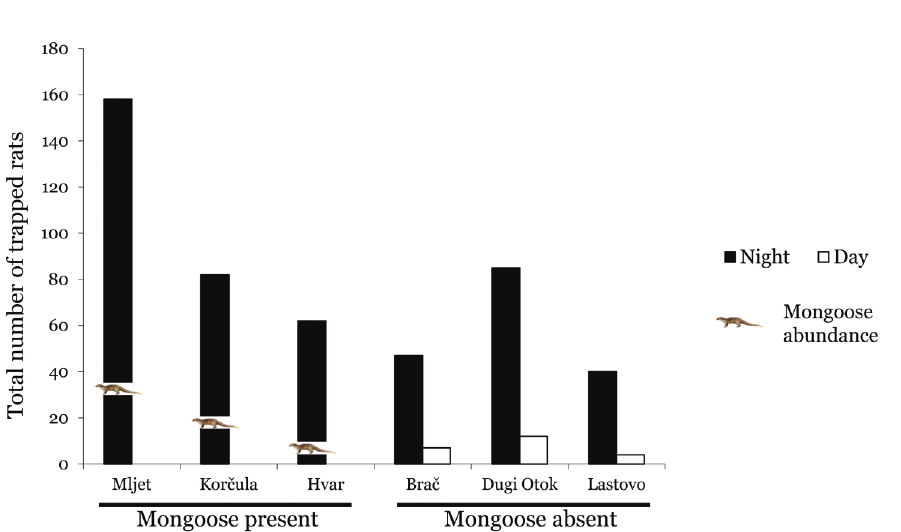
Figure 1. Total number (April and May) of trapped rats during the night and day on three islands with the mongoose and three islands without the mongoose. Mongoose abundance is illustrated with the pic- ture of a mongoose for each